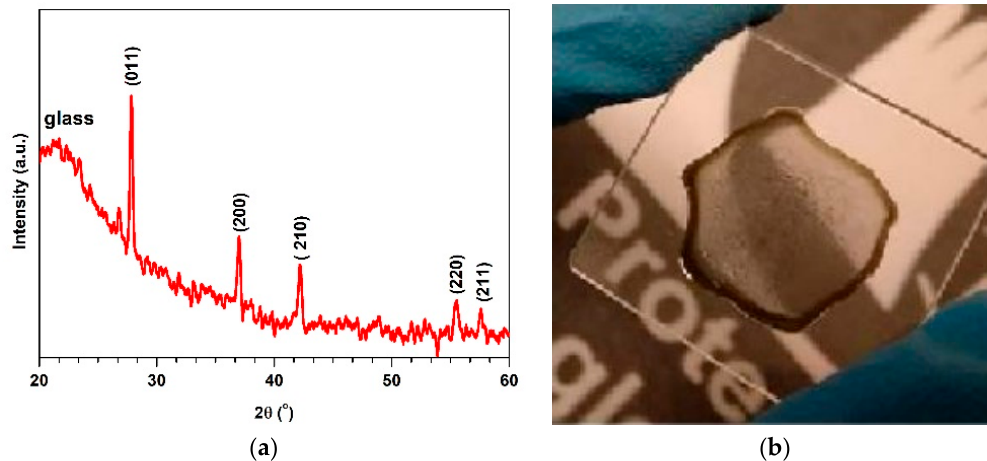
Figure 2. ( a ) XRD pattern and ( b ) image of VO 2 /Poly-Vinyl-Pyrrolidone (PVP) nanocomposite film with ratio VO 2 /PVP = 0.8 deposited on fused silica substrate.